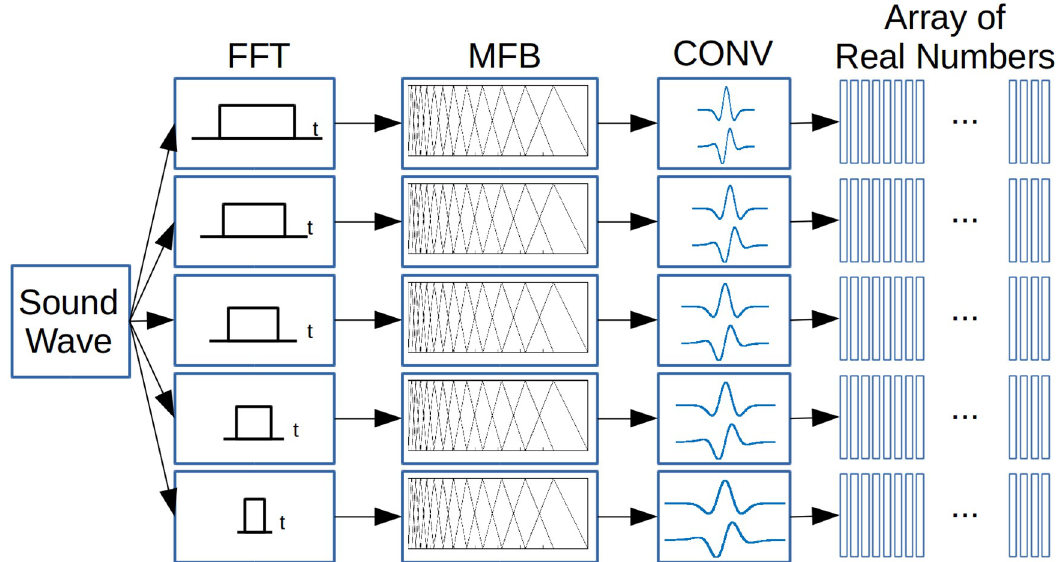
Fig 3. Multiresolution Spectro-Temporal Sound Analysis (MRSTSA) algorithm. Sound waves are processed by FFTs with different time windows, then each spectrum is processed by a Mel Filter Bank (MFB) and each resolution is convolved with a complex signal with a different coefficient. Finally, each filter coefficient is obtained computing the modulus from the convolution and then applying an automatic gain control.